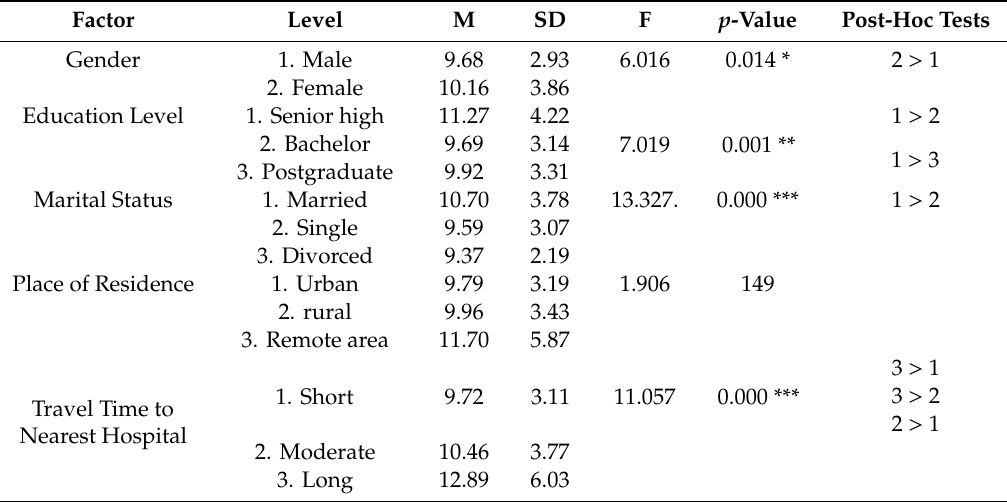
Table 2. Summary of ANOVA results on CIFS